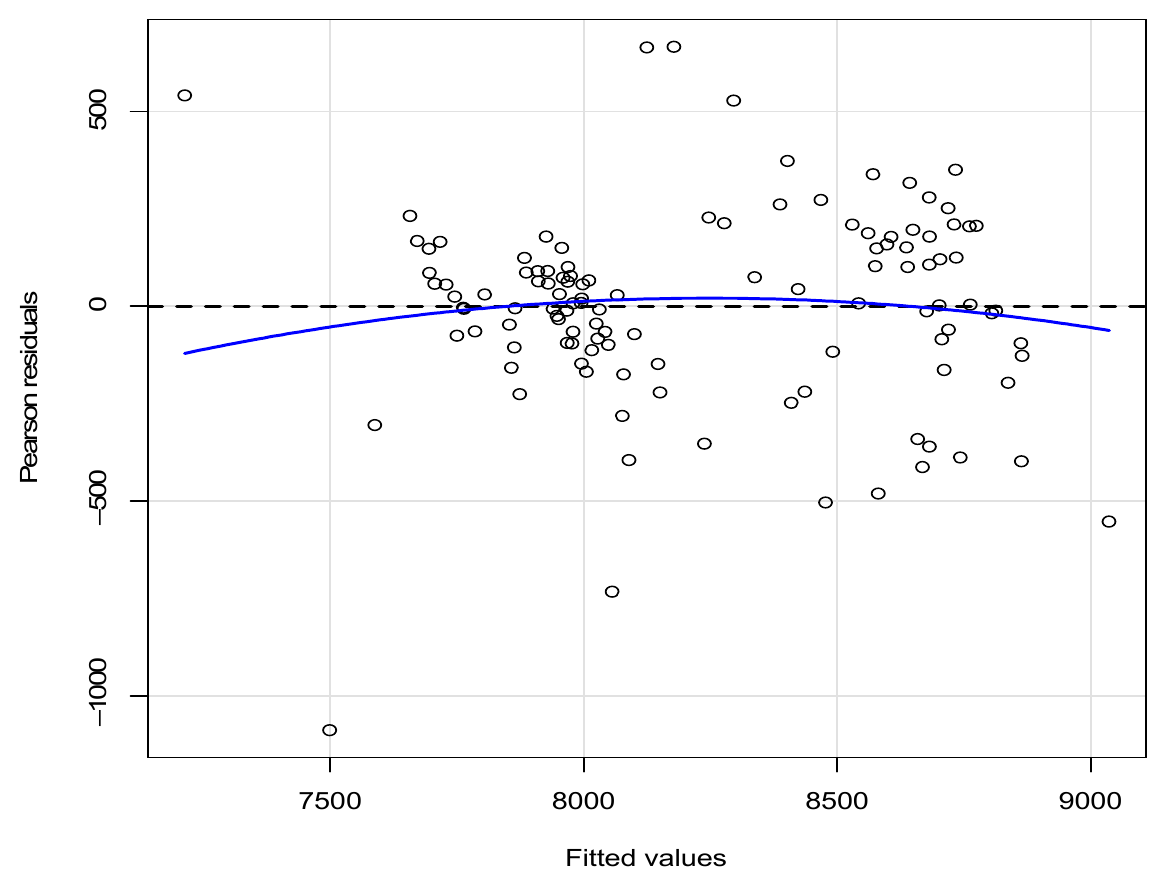
Figure 6. Bivariate regression model regressing average STP on average pump rate .